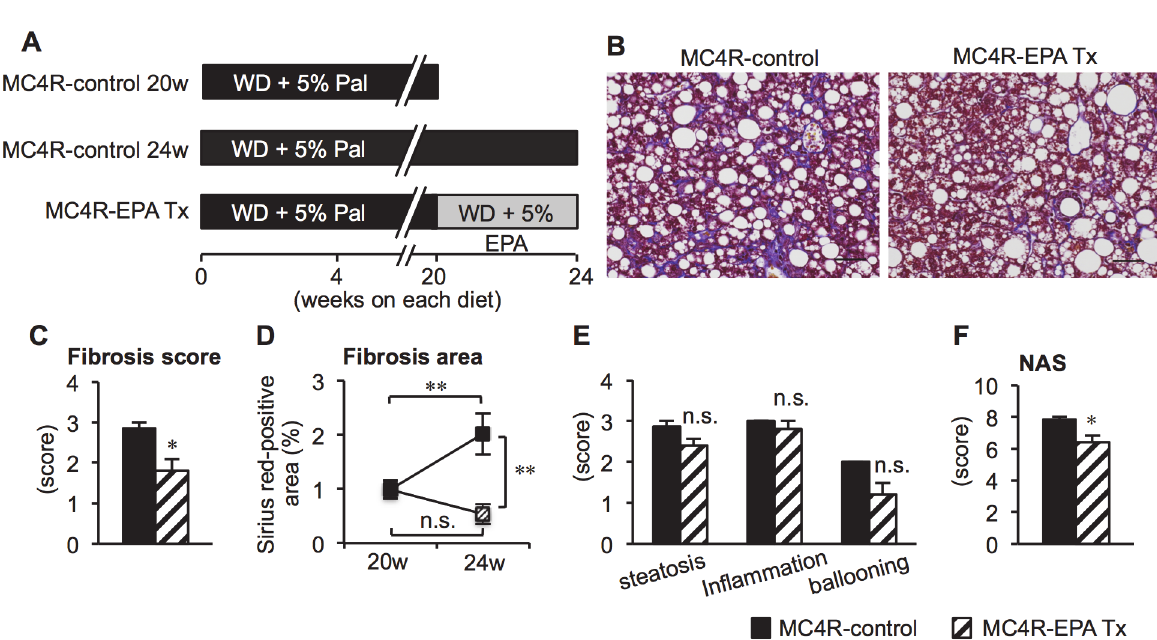
Fig 6. Histological analysis of the liver of MC4R-KO mice treated with EPA for 4 weeks after the development of NASH. (A) Experimental protocol of therapeutic EPA treatment. Fibrillar collagen deposition evaluated by Masson-trichrome staining (B) and fibrosis scores (C). (D) Quantification of Sirius red- positive area. Scores of steatosis, lobular inflammation, ballooning degeneration (E) and NAS (F). Scale bars, 50 μ m. * P < 0.05; ** P < 0.01; n.s., not significant. MC4R-control, n = 7; MC4R-EPA Pre, n = 10.